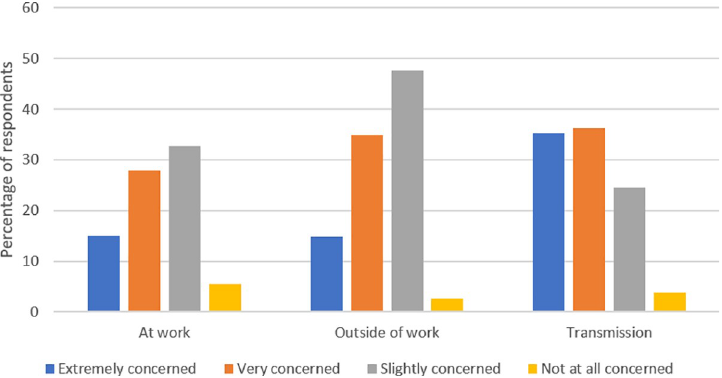
Fig 2. Concern regarding acquisition and transmission of COVID-19. This figure illustrates allied health professionals’ level of concern of acquiring COVID-19 at work or outside of work, as well as transmission to others. A larger percentage of respondents reported high levels of concern regarding transmission of COVID-19 to